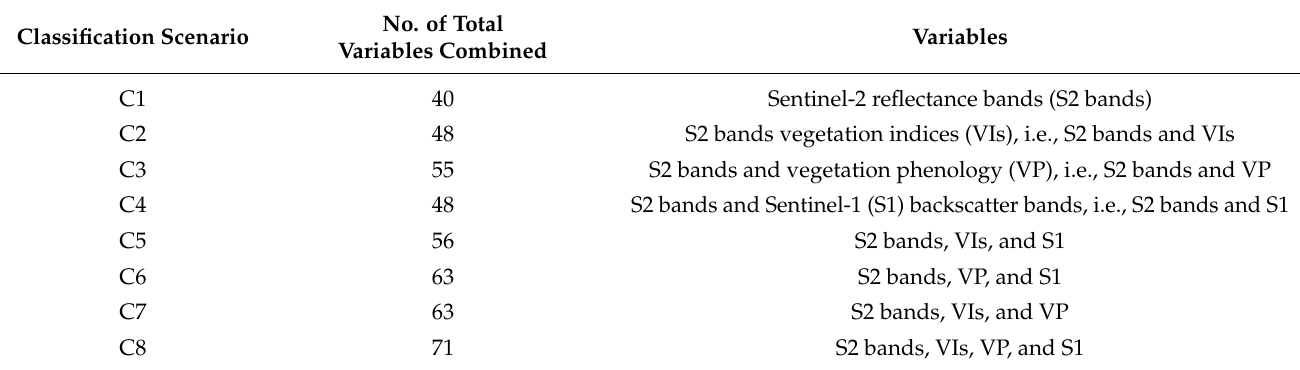
Table 7. The classification scenarios and the remotely sensed variables that were used in each scenario. No. of Total Classification Scenario Variables Combined